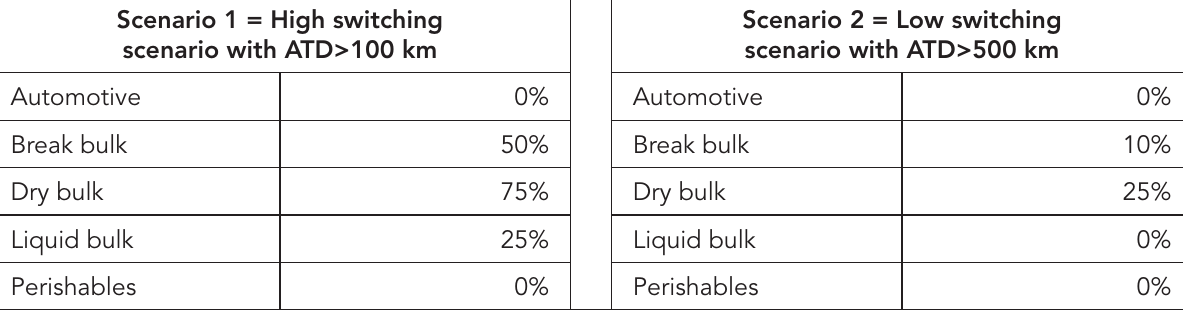
Table IV: Market share scenarios for switching traffic to branch